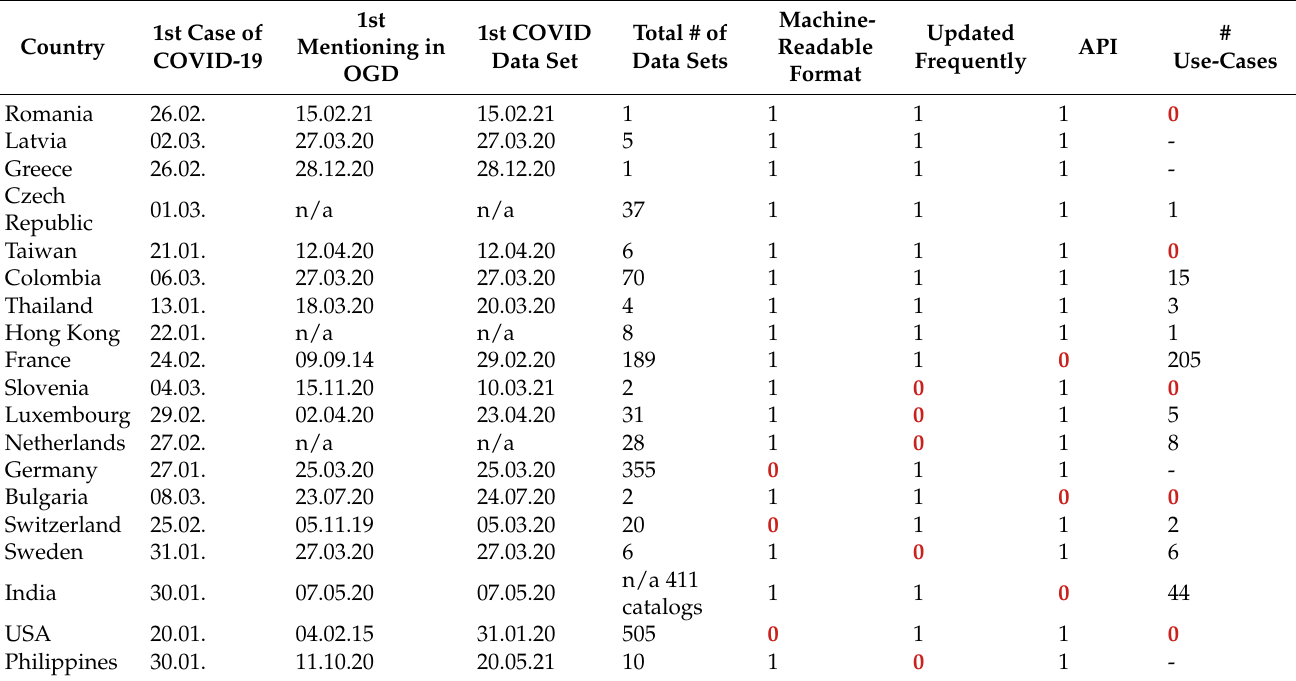
Table 8. COVID-19 data: TOP-10 OGD